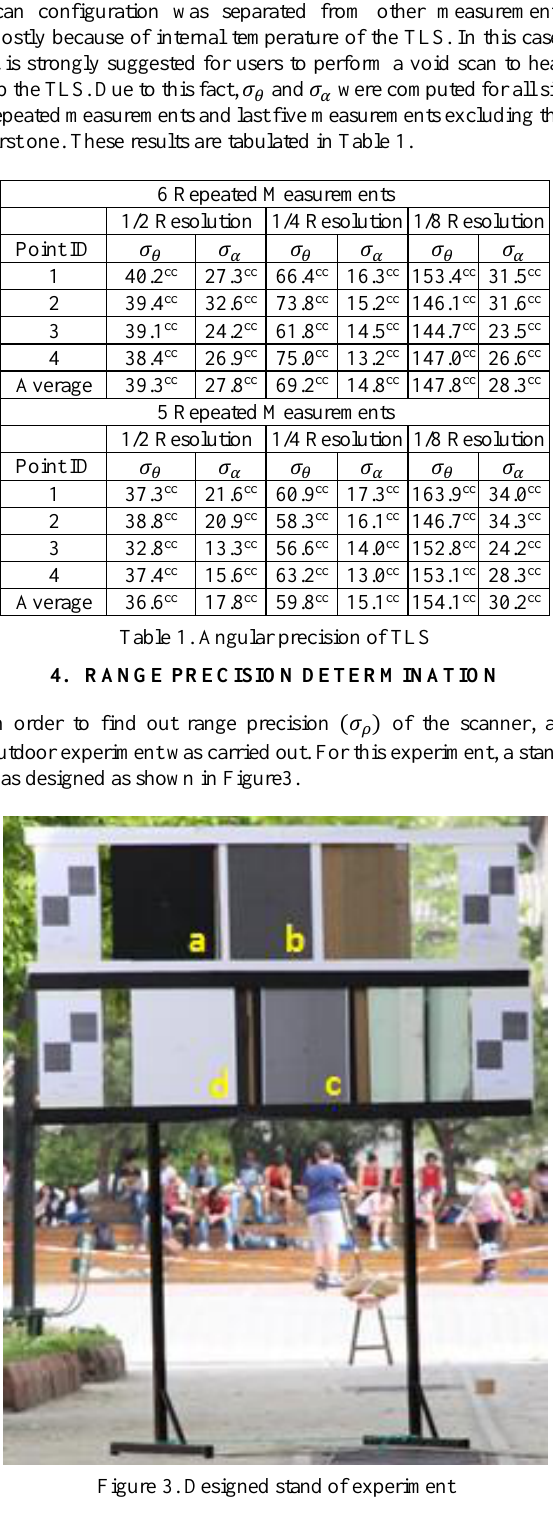
Figure 3. Designed stand of experiment